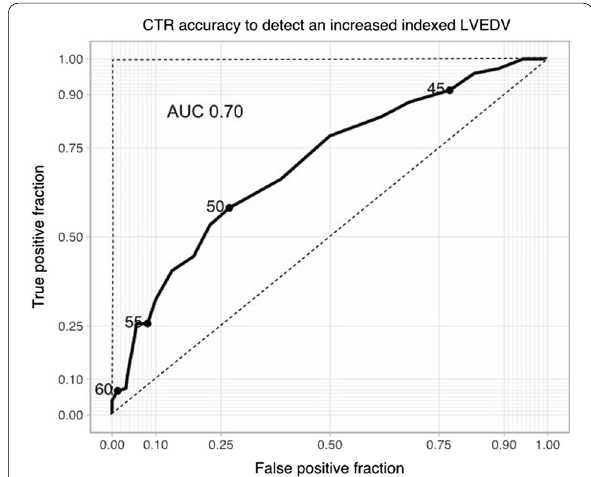
Fig. 5 ROC curve of CTR and increased LVEDV. ROC curve illustrating diagnostic accuracy of multiple CTR cut-off values to detect an increased LVEDVi. The X -axis shows true positives for each cut-off (an increased LVEDV on cardiac MRI is seen by the defined cut-off). The Y -axis shows false positives (normal LVEDV on cardiac MRI, which is characterised as increased based on a given CTR value). Higher CTR values give few false positives at the expense of many false negatives (many patients with an increased LVEDV are missed). Lower CTR values diagnose most patients with an increased LVEDV at the expense of many false-positive results. The area under the ROC curve describes the overall diagnostic power of CTR. An ideal test would have no false positives or false negatives (AUC 1 = described by the 90° dashed line). Random guessing would render 50% of true positives and 50% of false positives (AUC 0.5) and is = represented by the no-discrimination line (45° dashed diagonal line). CTR cardiothoracic ratio, LVEDVi left ventricular indexed end-diastolic volume, AUC area under the curve. Other parameters are available